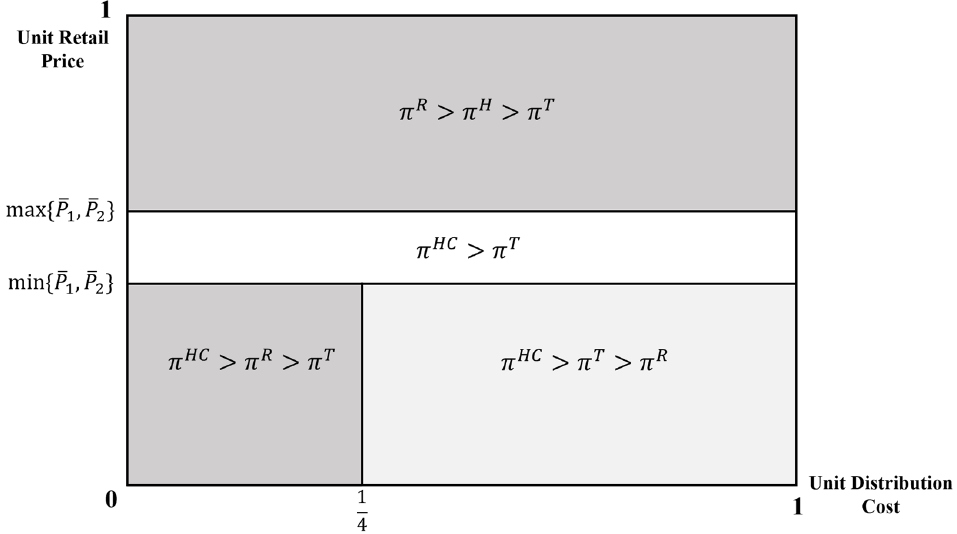
Figure 9. Operating enterprise business model selection path diagram in competition cases.